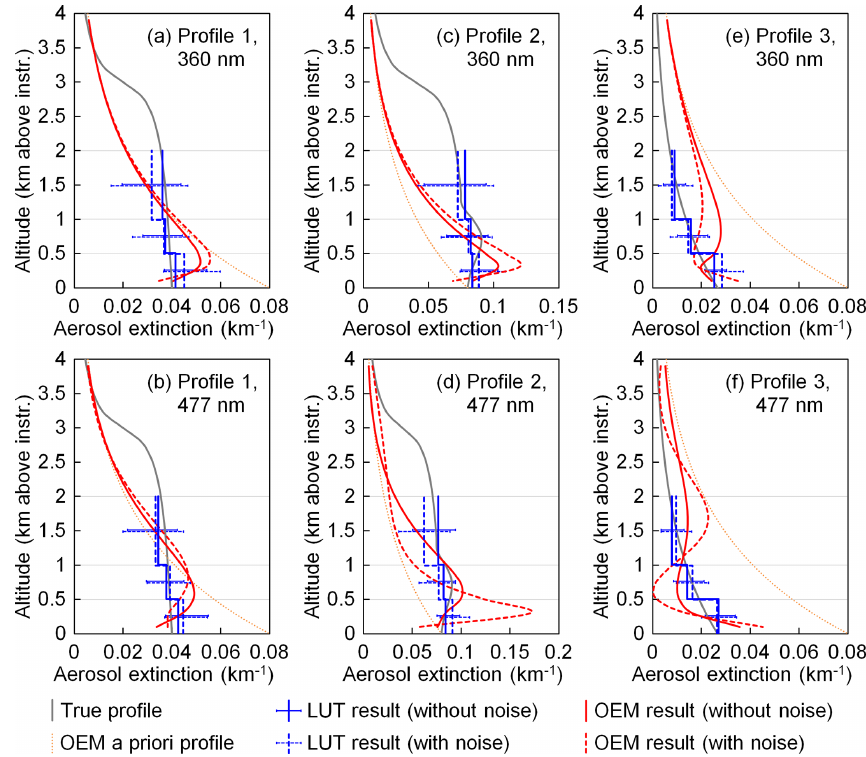
Figure 13. Retrieval results of three synthetic profiles. The grey curves show the true profiles, with which the synthetic O 4 DSCDs were simulated. The blue and red curves represent the profiles retrieved using our LUT (lookup table) algorithm and a typical OEM (optimal estimation method) algorithm, respectively. The sold blue and red curves represent the profiles retrieved from the original synthetic data, and the dashed curves represent the profiles retrieved from the synthetic data with random noised added. The error bars of the blue curves indicate the uncertainties calculated by Eqs. (16) and (17). The dotted orange curves are the a priori profile used in the OEM